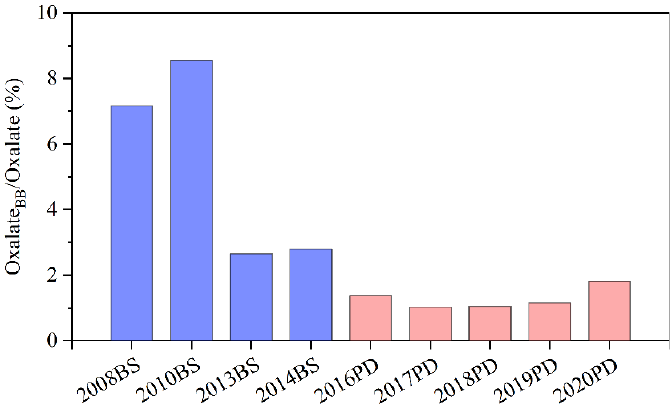
Figure 3. Annual BB contribution to oxalate in Shanghai. Blue bars represent BS and red bars represent PD.